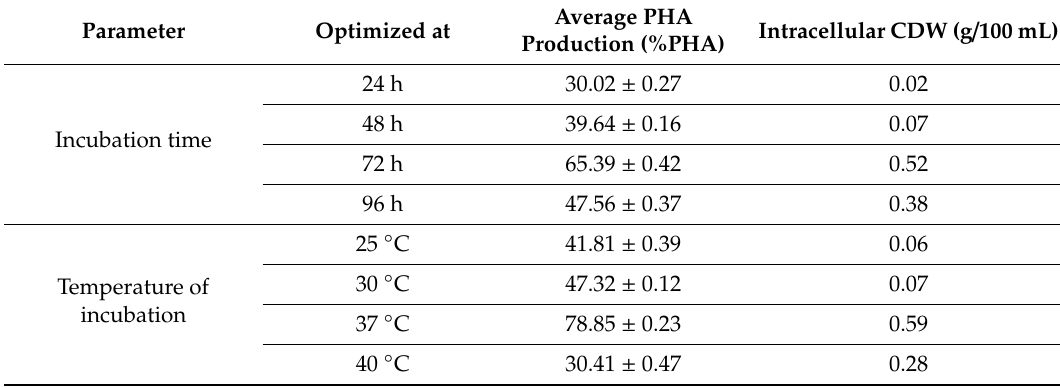
Table 4. Comparison of maximum PHA produced during optimization of various cultural conditions. Parameter Optimized